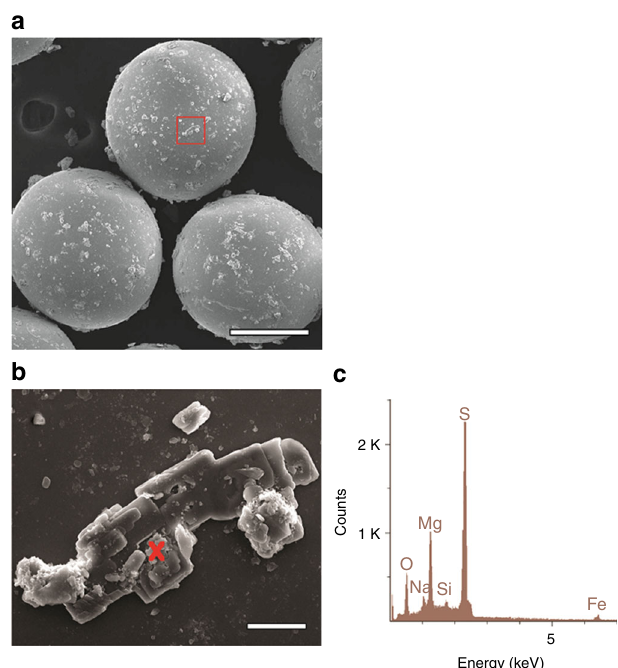
Fig. 1 SEM secondary electron images and EDS spectra of experimental products recovered after 12 days at − 60 °C. Recovery was accomplished by freeze drying rather than quenching with NaOH solution (see Methods: Quenching Procedure and Analysis). a Run products are located on 400 µ m glass spheres used in experiments. Scale bar is 200 µ m b Magni fi ed view of mineral grain identi fi ed with red box in 1A. Red cross indicates location of EDS measurement. Scale bar is 10 µ m c Energy Dispersive X-ray Spectroscopy (EDS) data that show substantial enrichments in Mg and S consistent with the presence of a Mg-sulfate